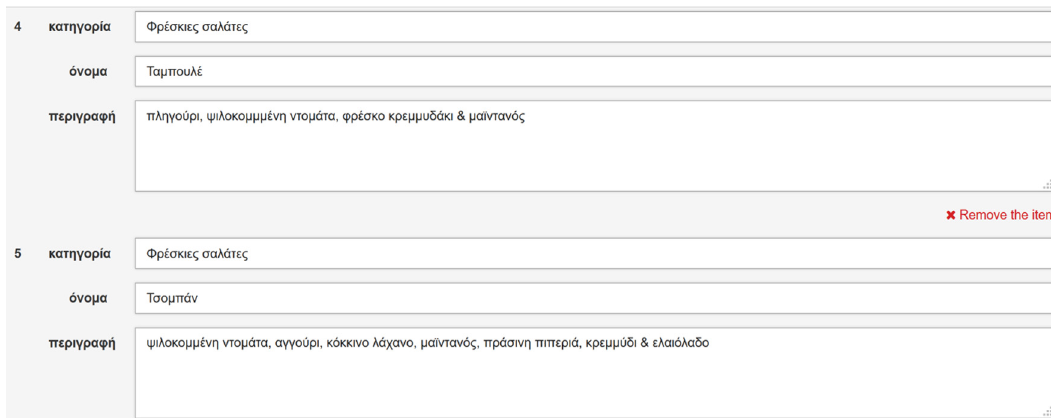
Figure 2: The entries for two dishes in the category “ fresh salads. ” Slots from top to bottom: category, name, and